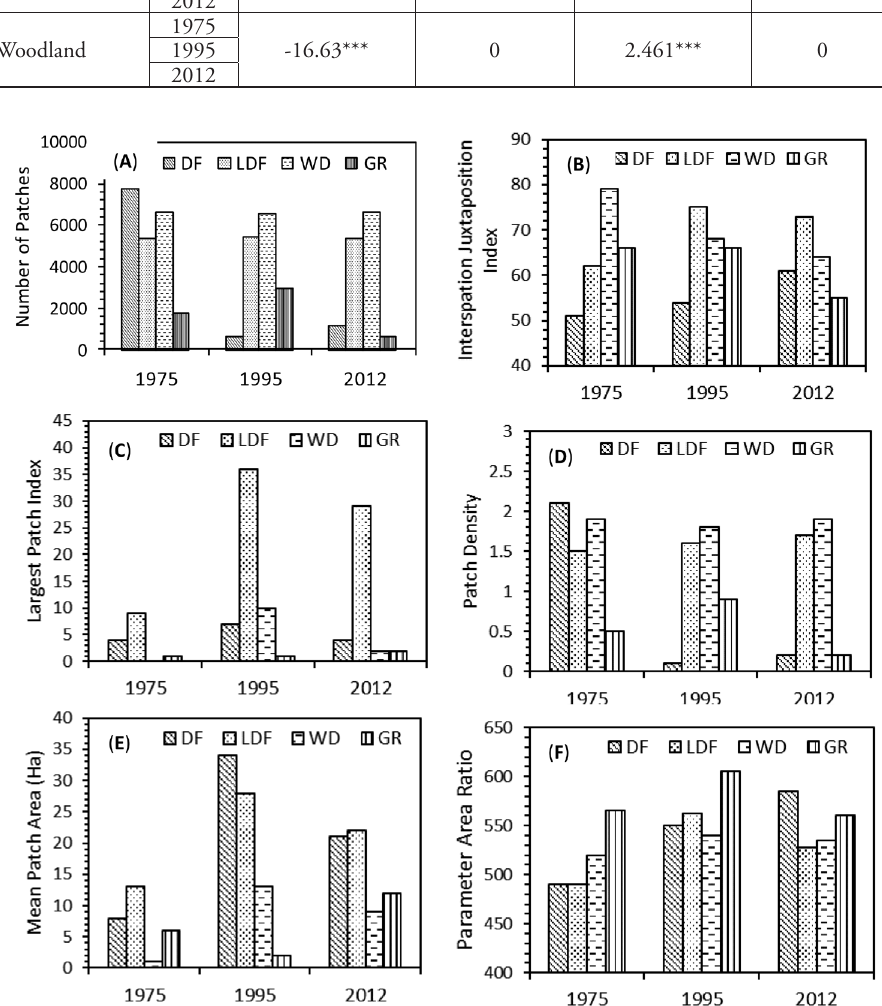
Figure 4. Spatial variability in number of patches ( A ), Interspersion Juxtaposition Index ( B ), Largest patch index ( C ), Patch density ( D ), Mean patch area ( E ) and Perimeter area ratio ( F ) in 1975, 1995, and 2012. DF- dense forest, LDF-less dense forest, WD-woodland,